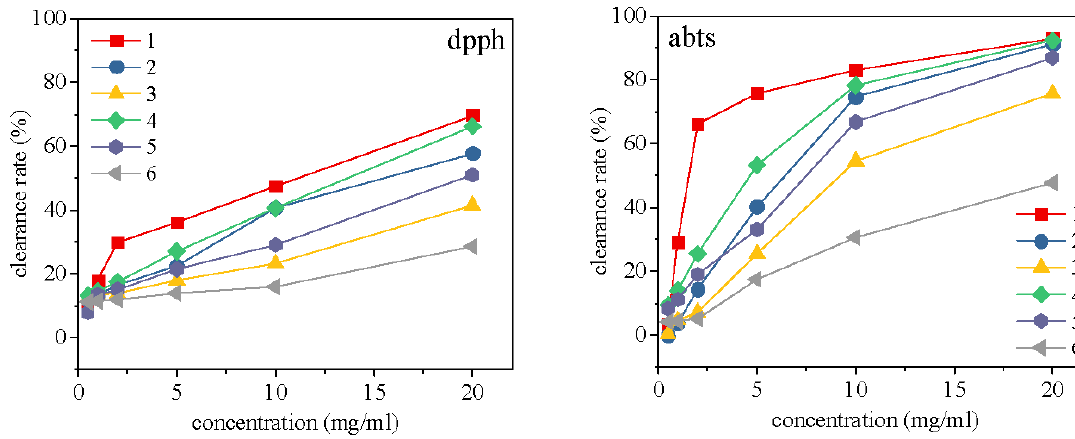
Figure 3. Antioxidant of flowers.